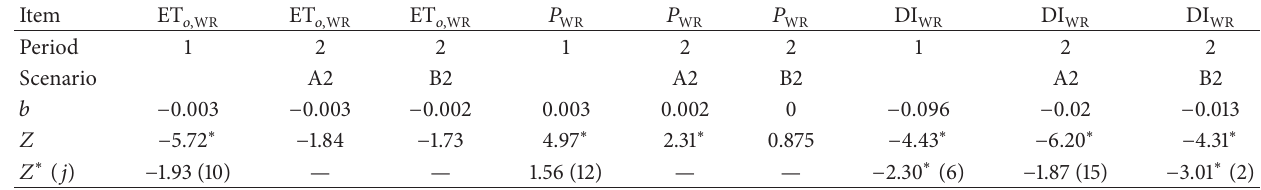
Table 6: Trend detection results of 𝑃, ET 𝑜 , and DI in the whole region. Period 1: 1961–2010, period 2: 2015–2099, and b -Sen’s